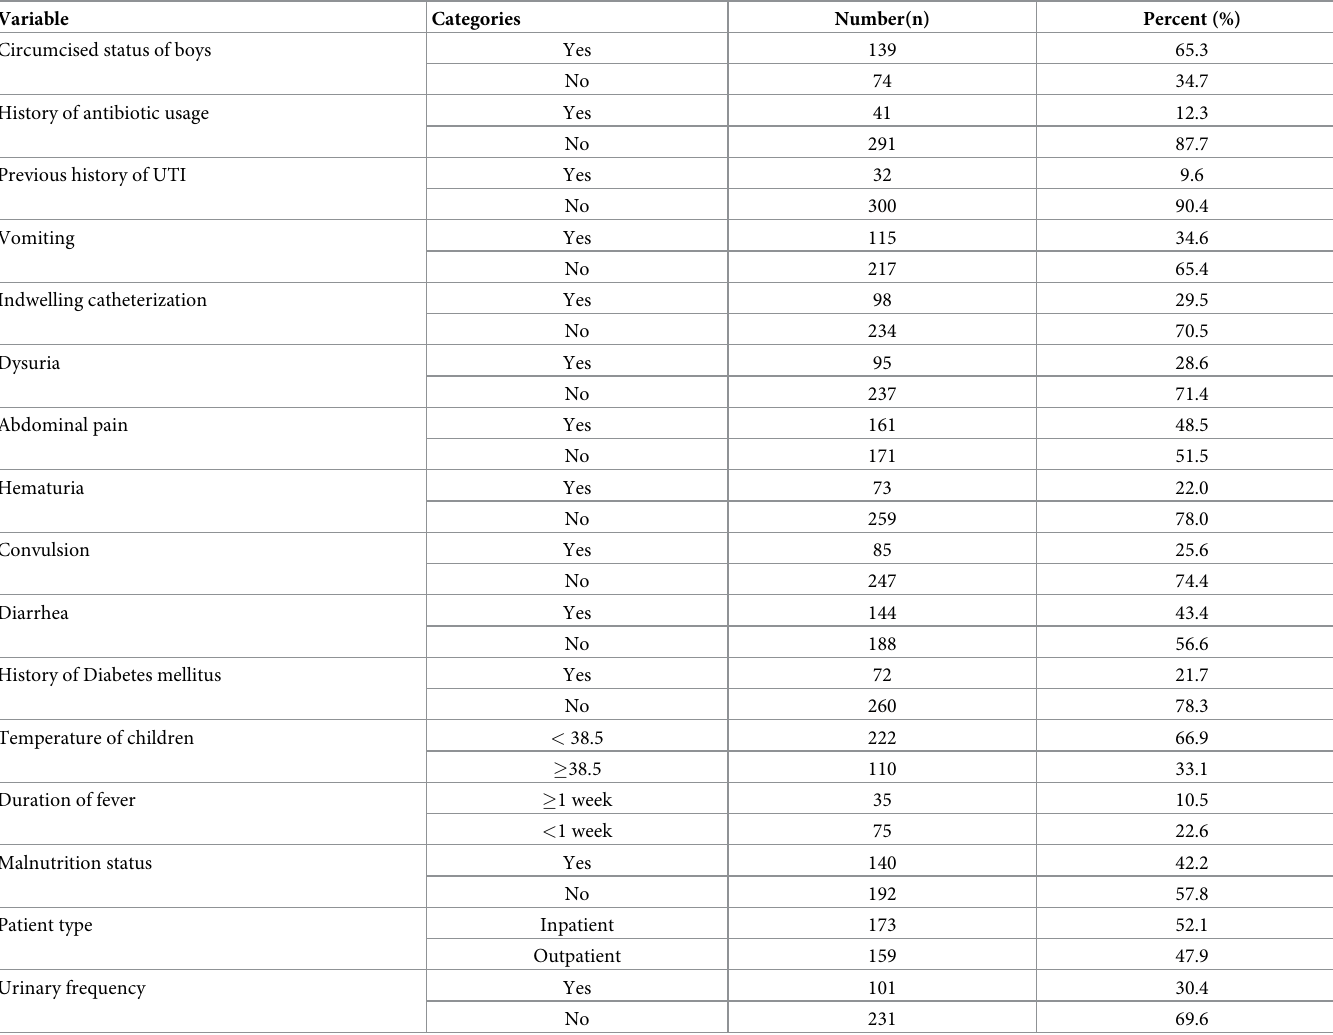
Table 2. Clinical future and medical history of under-five children at HFSUH, eastern Ethiopia, 2021 (n =